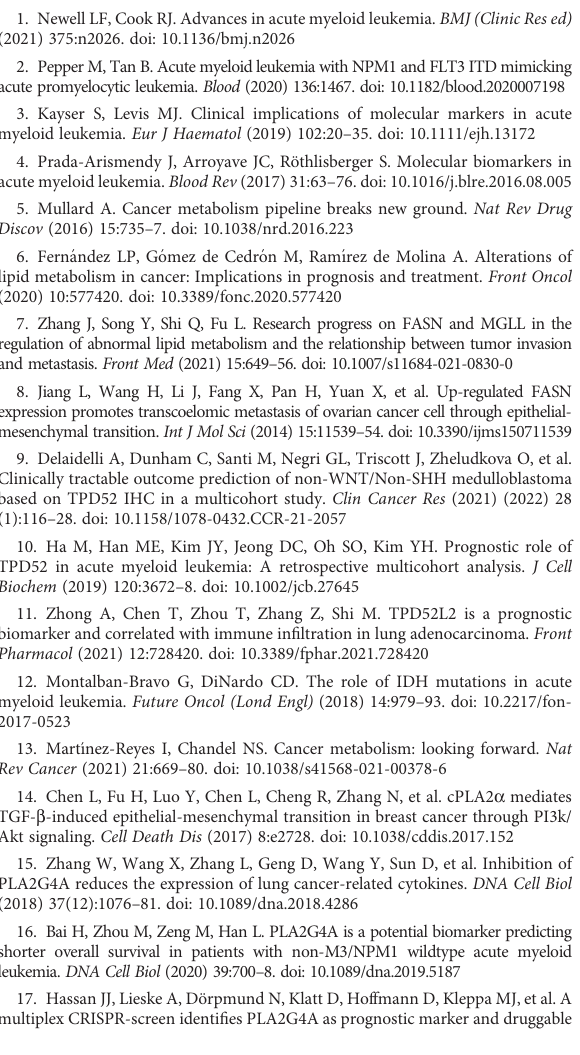
SUPPLEMENTAL TABLE 1 The clinical characteristics for AML cases in